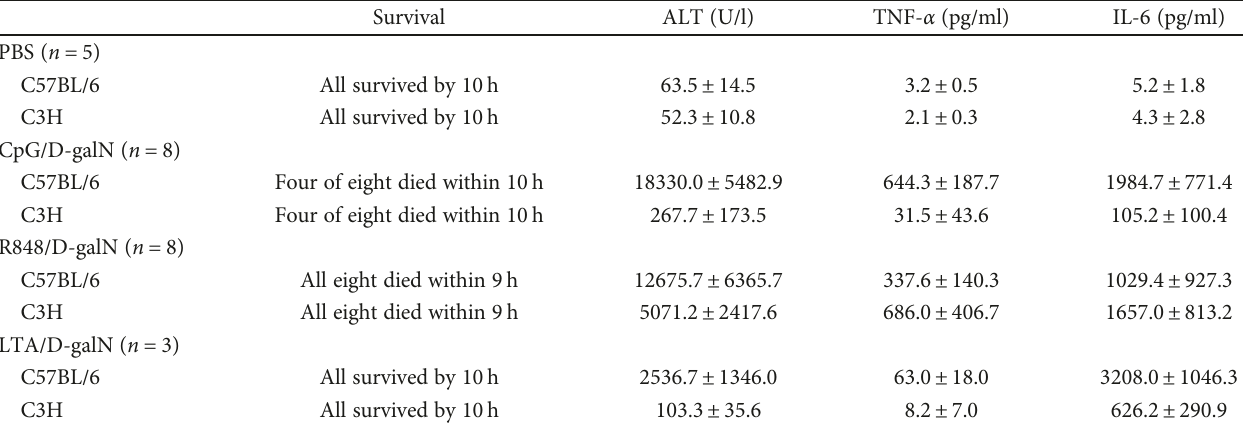
Table 2: E ff ect of CpG (20 μ g), R848 (10 μ g), and LTA (100 μ g) in D-galN- (20 mg/mouse) sensitized mice. Mean ± SD is